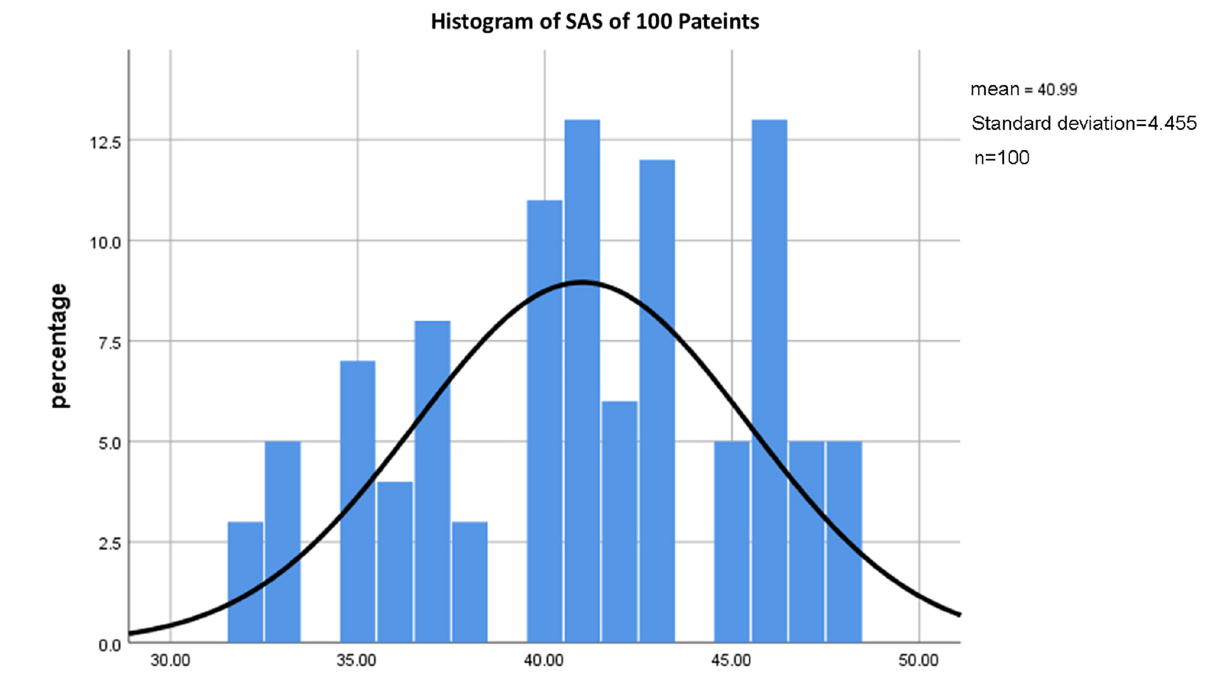
FIGURE 1 | Histogram of SAS of 100 patients. The histograms of the SAS scores of all patients showed that all patients had a score less than 50. The highest preoperative SAS score was 48. Patients with a SAS score of 48 accounted for 5% of all